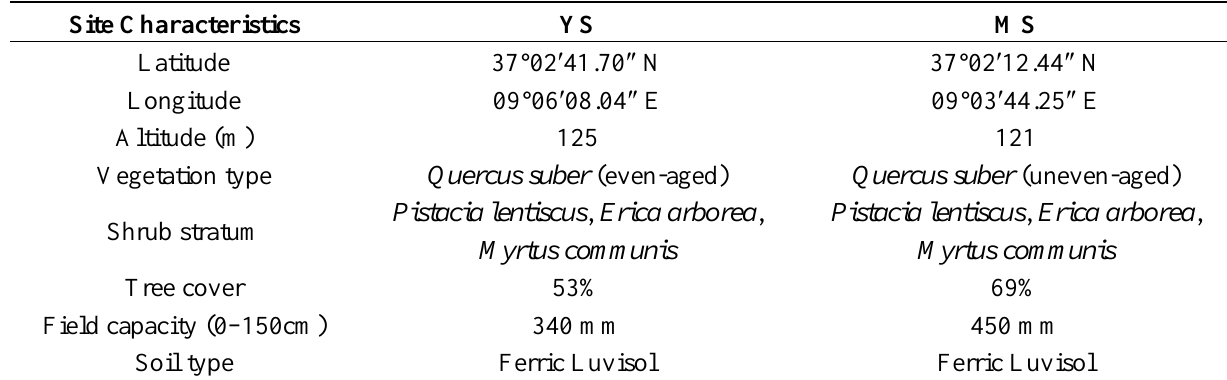
Table 1. Main characteristics of the young stand (YS) and the mature stand (MS) at the Bellif forest study